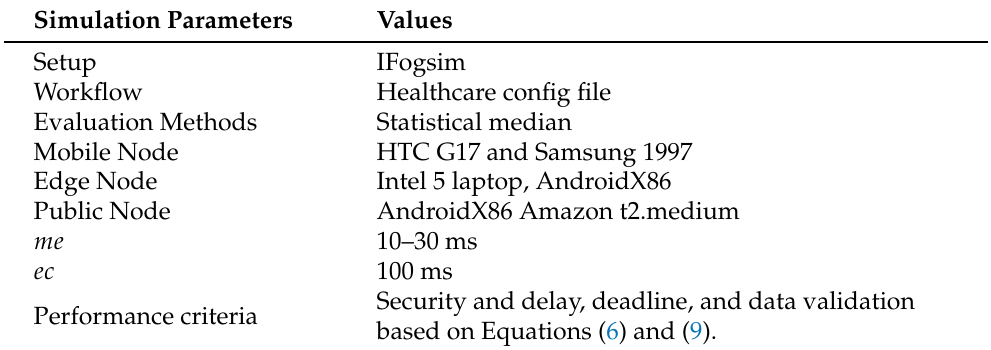
Table 3. Lfogsim-based experimental parameters.